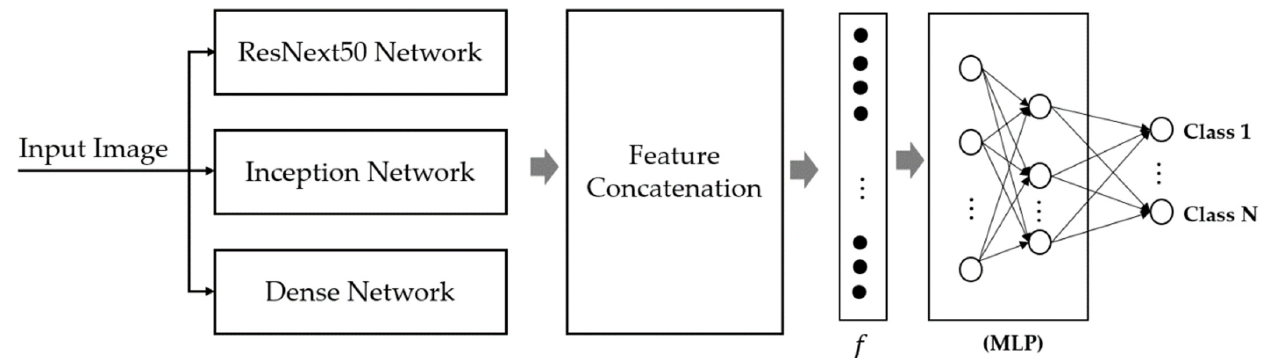
Figure 4. Our design for an MLP-based classification network for a small training dataset brain tumor classification problem.